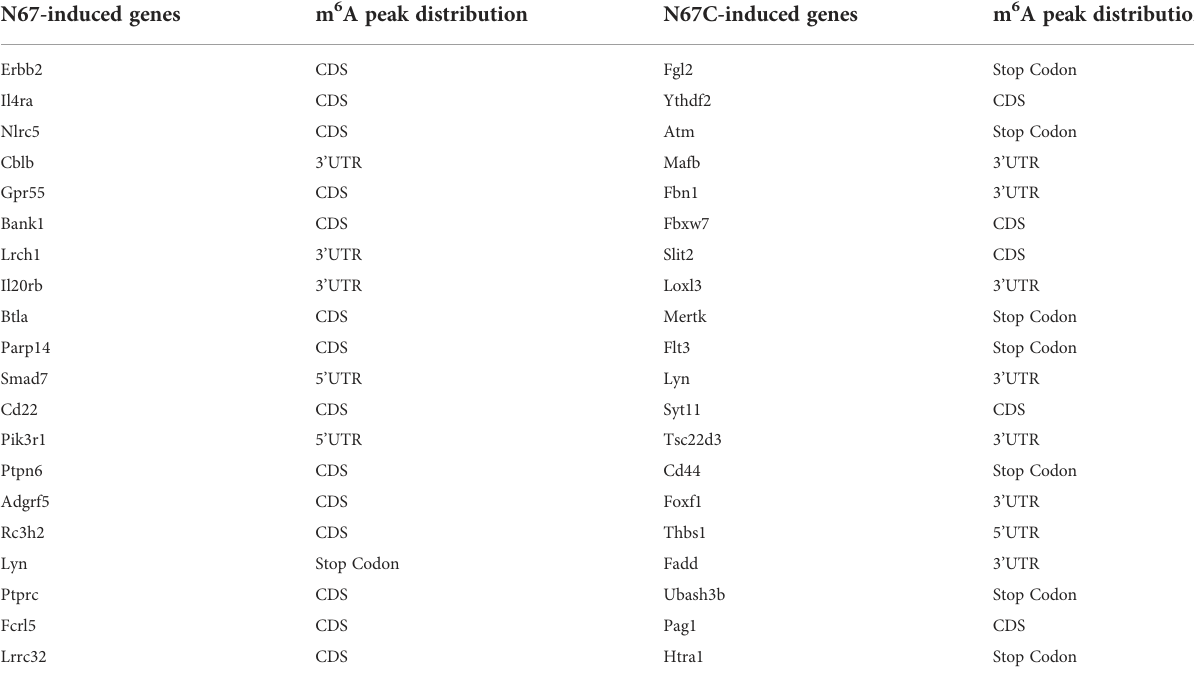
TABLE 2 Immune response related genes gained m 6 A peaks post malaria